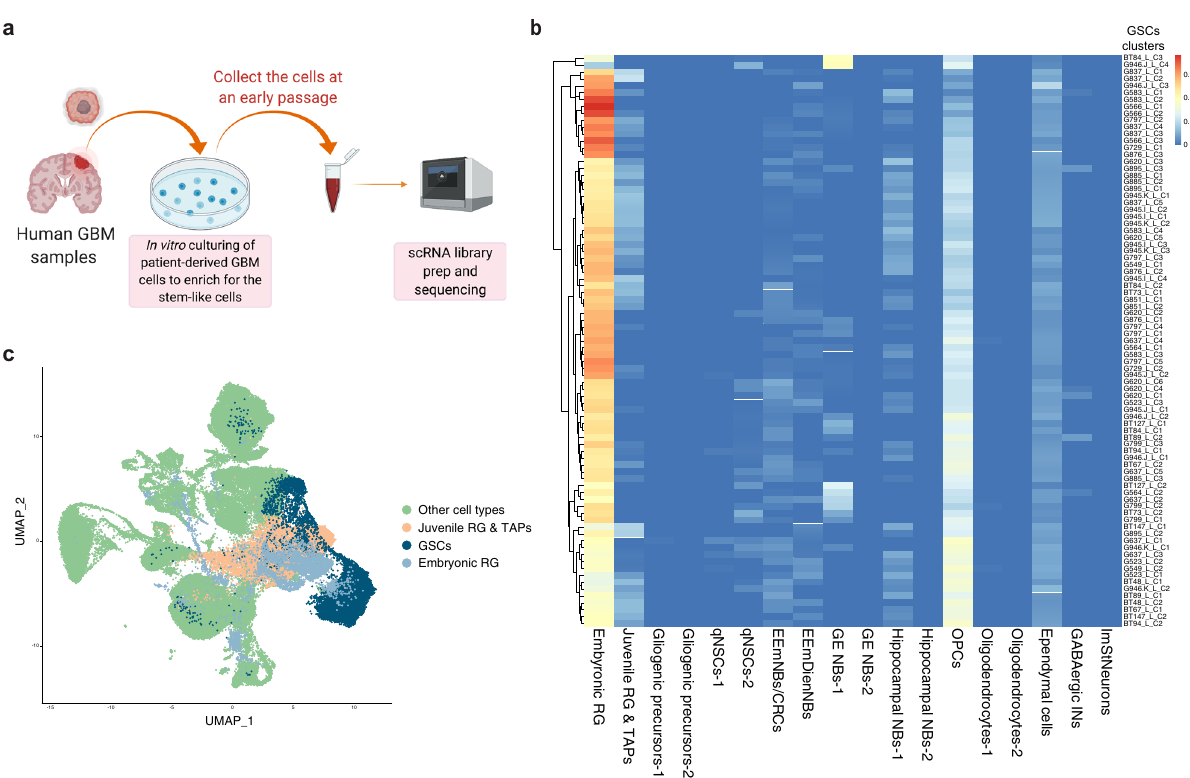
Fig. 6 GBM patient-derived cell lines are enriched for embryonic RG-like cells. a Overview of the experimental work fl ow for the collection of GBM stem cells (GSCs). b Deconvolution analysis heatmap of the GSCs clusters obtained from the scRNA-seq of 26 patient-derived GBM cultures from Richards et al. 2021 showing relative fraction of the mouse developmental cell-types for each GSC cluster. Each patient GSCs sample was clustered separately and the clusters are denoted as e.g. “ G523_Line_cluster#1 ” = “ G523_L_C1 ” . c Co-clustering of the GSCs obtained from the scRNA-seq of 26 patient-derived GBM cultures with the clusters from the mouse developmental dataset (see Methods). Abbreviations as in Fig.